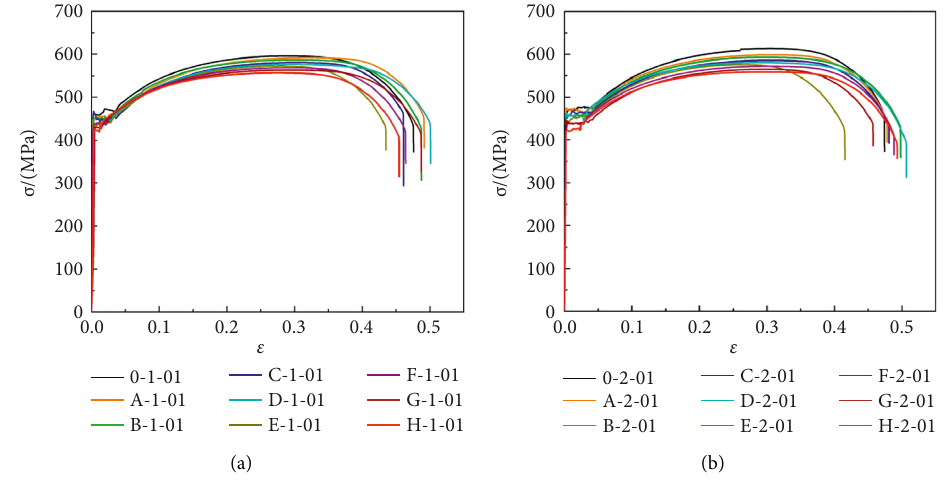
Figure 13: Stress-strain curves. (a) Carbon steel. (b) Weathering